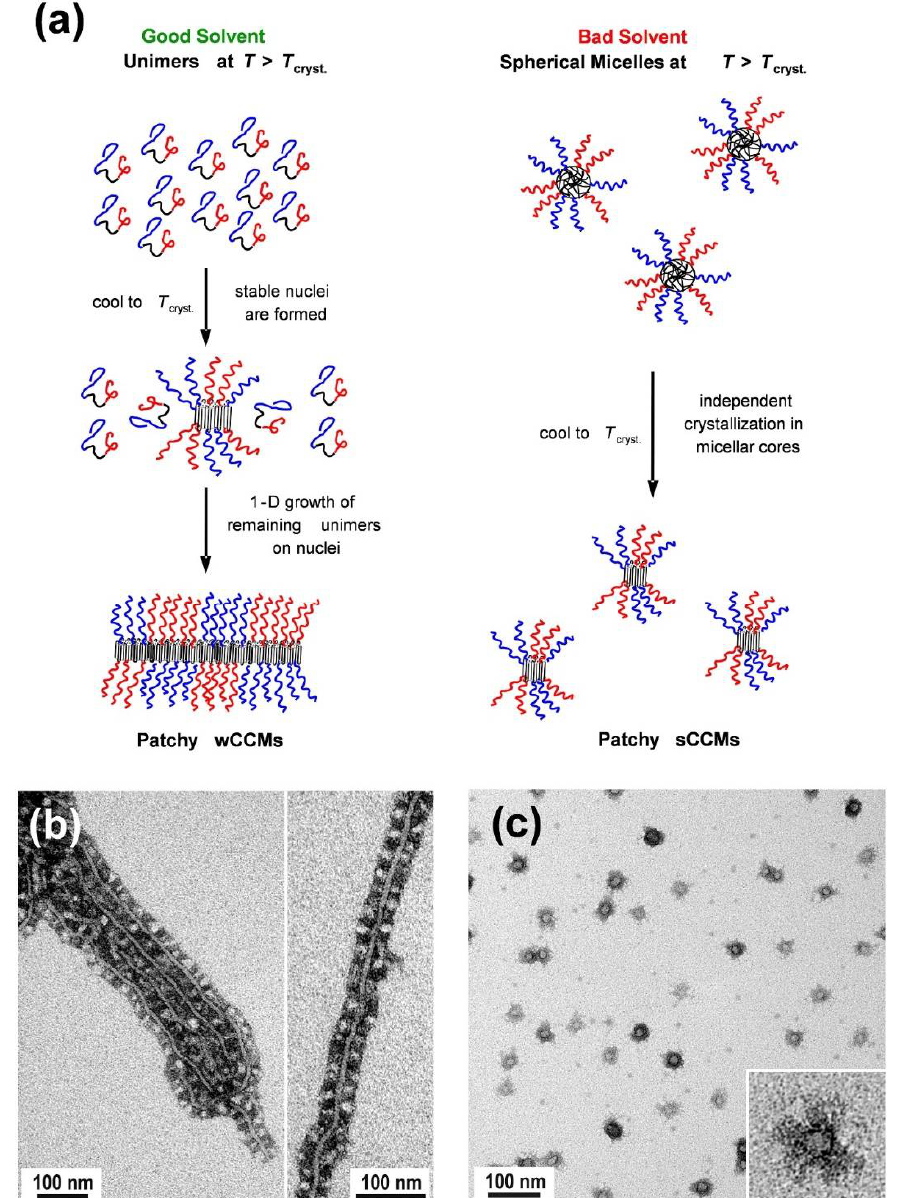
Figure 5. ( a ) Schematic representation of the proposed mechanism for the formation of patchy worm-like and spherical crystalline-core micelles (wCCMs and sCCMs, respectively) from SEM triblock terpolymers (PS blocks are represented in blue, PE in black, and PMMA in red). TEM images of ( b ) patchy S 340 E 700 M 360 wCCMs prepared by CDSA in THF and subsequent annealing at 45 °C for 3 h, and ( c ) patchy S 340 E 700 M 360 sCCMs formed in dimethylacetamide (subscripts denote the respective average degrees of polymerization, PS was selectively stained with RuO 4 vapor and appears dark). Reproduced from [94] with permission of ACS.